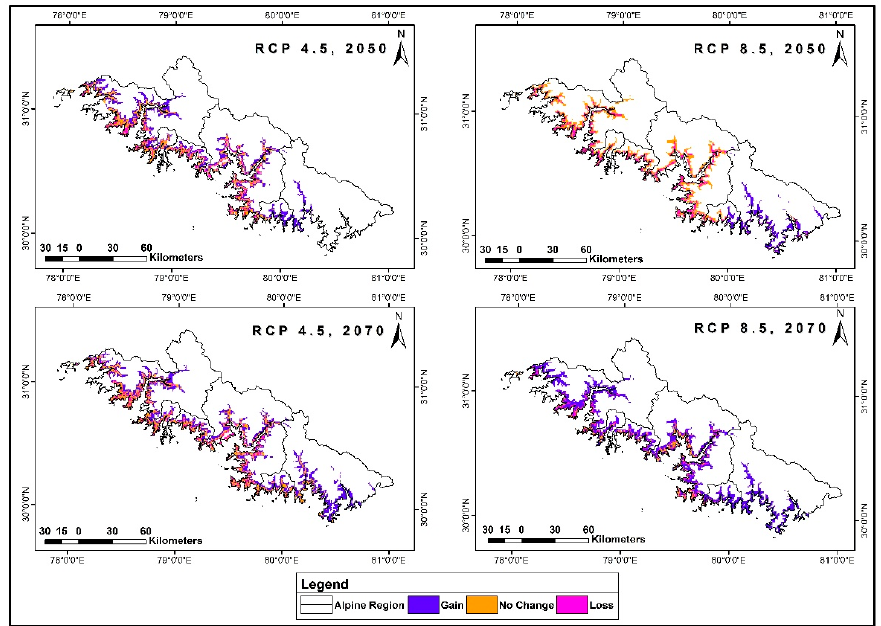
Figure 6. Predicted range contraction for C. cordigerum .